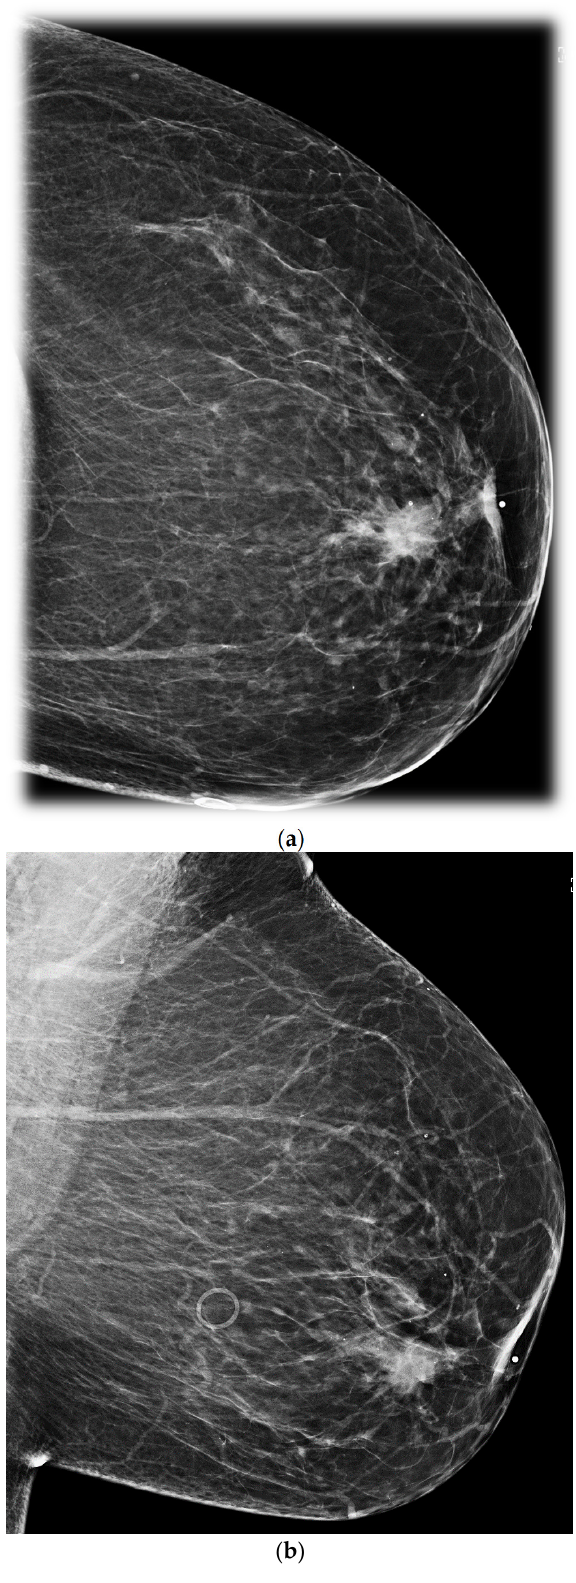
Figure 1. Retroareolar carcinoma. CC ( a ) and MLO ( b ) mammograms show a spiculated irregular mass containing intralesional calcifications. The mass measures 17 mm and is located in the retroareolar region at less than 2 cm from the nipple and associated with a nipple inversion.